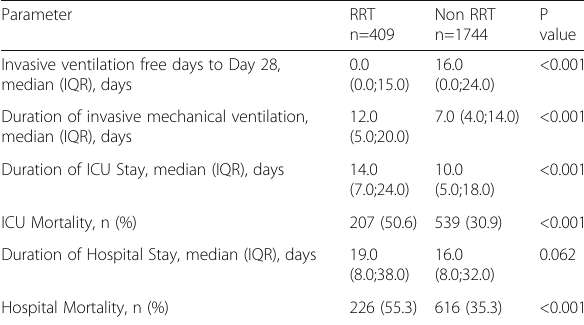
Table 1 (abstract 0070). Association among RRT and outcomes in patients with ARDS. Differences among groups were tested using a